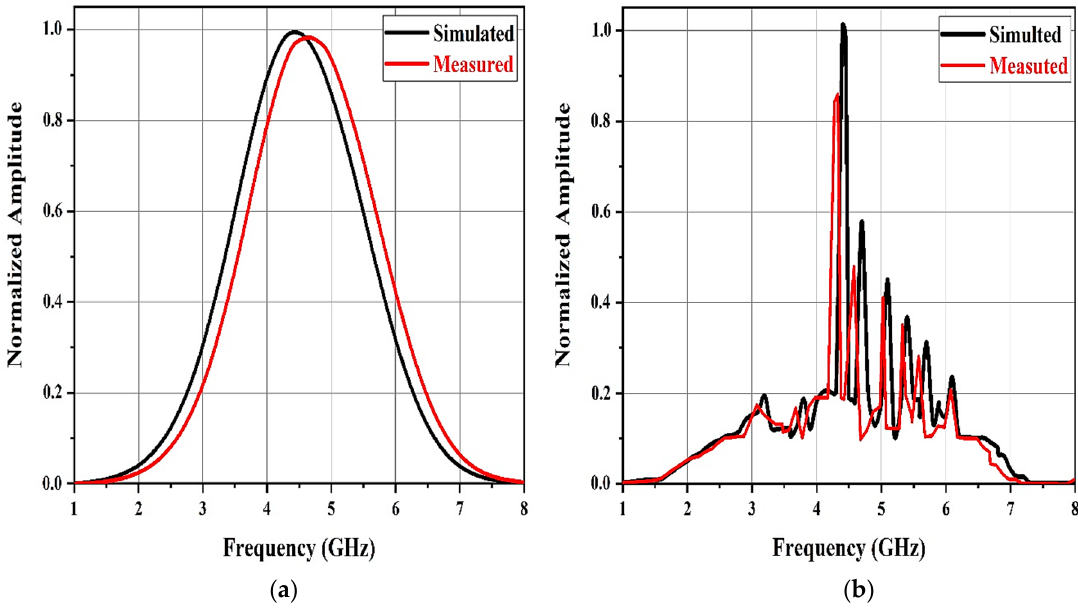
Figure 13. Measured normalized amplitude spectra of ( a ) the structural mode ys(t) and ( b ) the antenna mode backscatter ya(t).